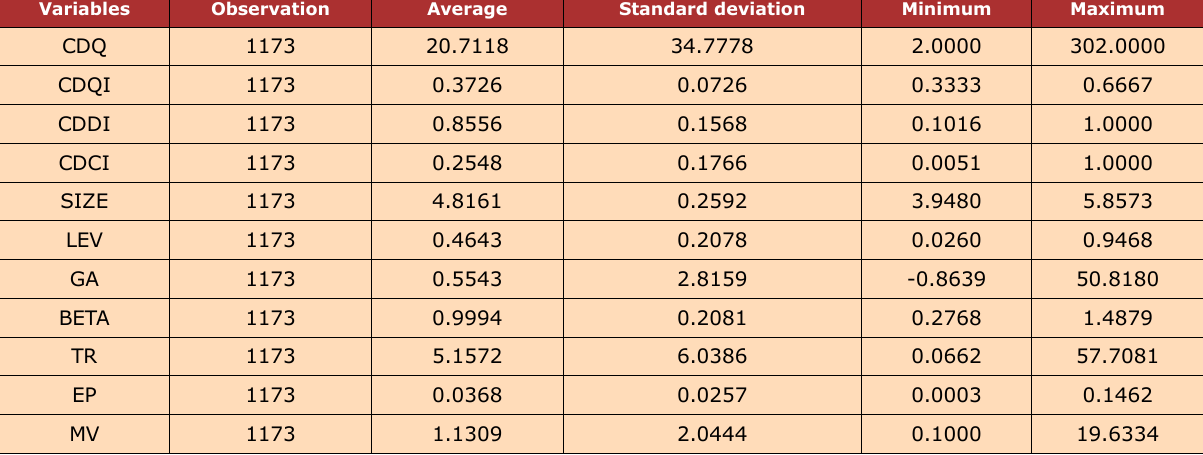
Table 2. Basic descriptive statistics of